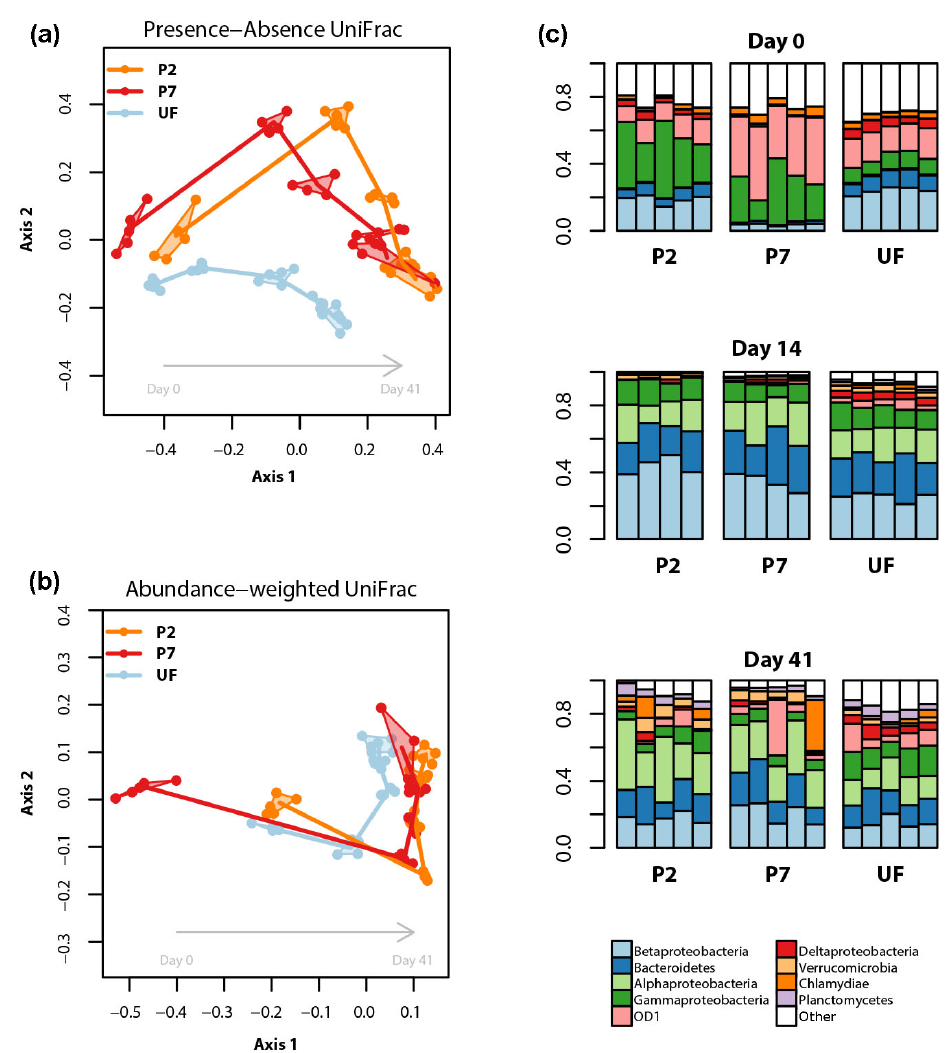
Figure 4. Bacterial dynamics for each of the filter treatments during the incubations. (a, b) NMDS ordinations based on presence–absence (a) or abundance-weighted (b) UniFrac distances; clusters (convex hulls) for each day × treatment combination are plotted; the lines join the centre of each cluster following the sequence of sampling. (c) Relative read abundances of the nine most abundant bacterial (sub-) phyla, based on 16S rRNA gene amplicon sequence data, separated by sampling time and treatment. Each column represents an experimental replicate. “Other” contains both unassigned bacterial reads and reads assigned to less abundant taxa. See Supplement for univariate time series plots for the most abundant taxonomic